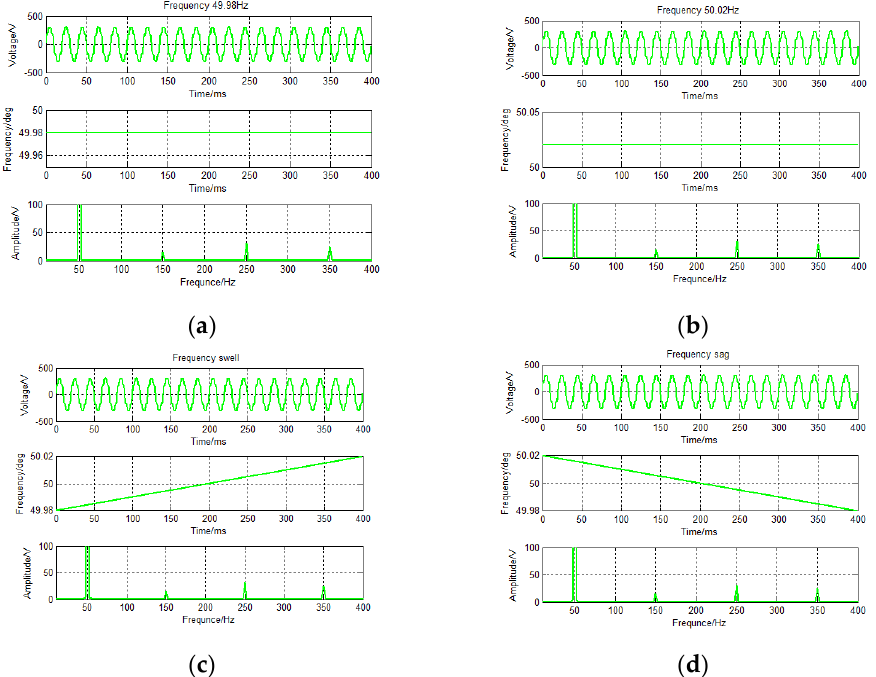
Figure 6. Simulation data for voltage frequency slight fluctuations. ( a ) Frequency 49.98 Hz; ( b ) Frequency 50.02 Hz; ( c ) Frequency swell; ( d ) Frequency sag.